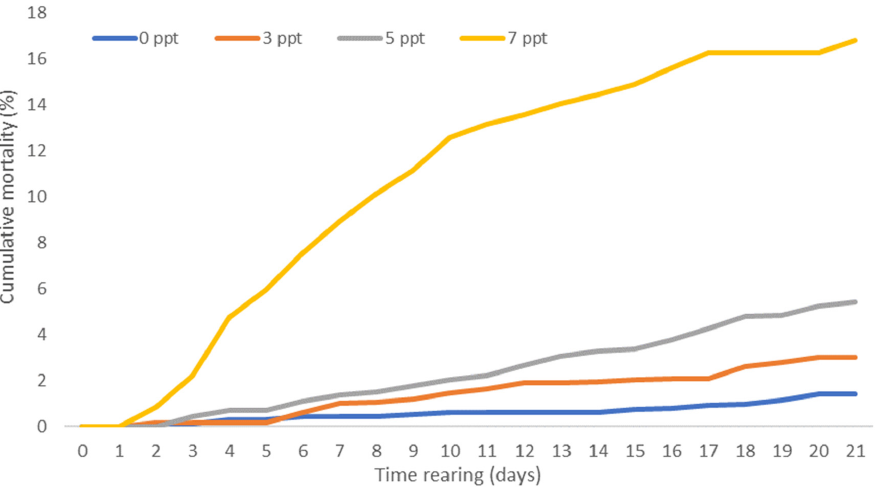
Figure 2. Cumulative mortality of blue bream Ballerus ballerus (L.) larvae reared in freshwater and water with salinity of 3, 5, and 7 ppt. Nearly 98.6% of individuals from the initial stock survived the experiment. A very similar survival rate of larvae was obtained when they were reared in water with salinity of 3 ppt. In this variant, 97% of the larvae survived the entire rearing period. The lowest survival rate of larvae was observed in water with salinity of 7 ppt, where 83.2% of larvae from the initial stock survived rearing (Table 1). Table 1. Results of rearing the blue bream Ballerus ballerus (L.) larvae in freshwater and in water with salinity of 3, 5, and 7 ppt. Mean value ± SD. Results in rows with the same letter index are not statistically significantly different ( α = 0.05). 0